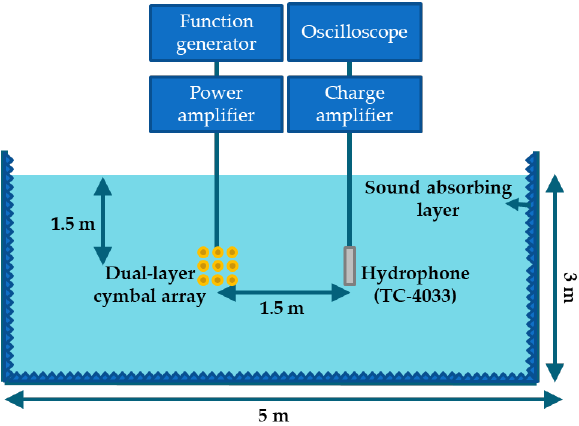
Figure 19. Prototypes of the two-layered cymbal arrays: ( a ) 3 × 3 array; ( b ) 5 × 5 array.